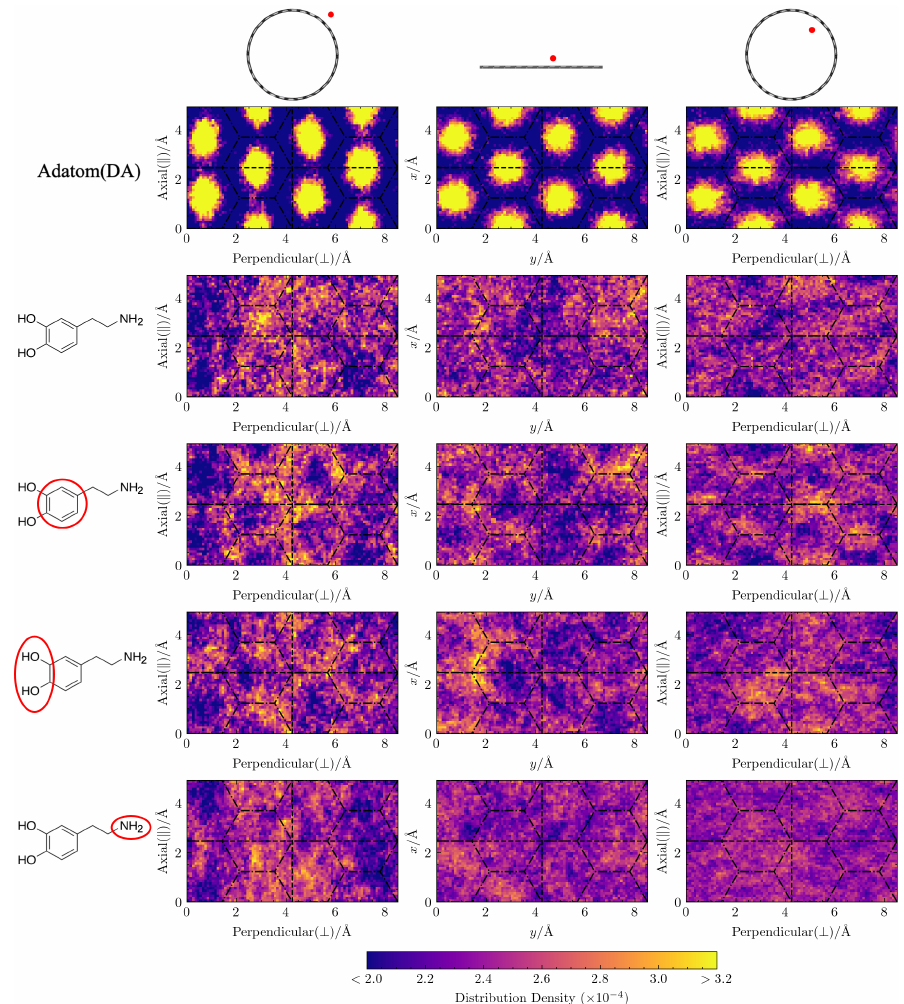
Figure 4. Lateral distributions of adatom(DA) and DA above the CNT and graphene surfaces. The plots show the distribution densities of the adsorbates above the carbon surface. From left to right, the columns show the distributions on the exterior surface of ( 15,15 ) -CNT, on flat graphene, and on the interior surface of ( 15,15 ) -CNT, as indicated with the cartoon images above each column. From top to bottom, the rows show the results for adatom(DA) (an atomic adatom with the mass of DA), the COM of DA, and the three COMs of the red-circled DA moieties. The projected COM coordinates are binned with a spatial resolution of 0.1 × 0.1 Å 2 and wrapped into 4 unit cells, which are separated by the dashed